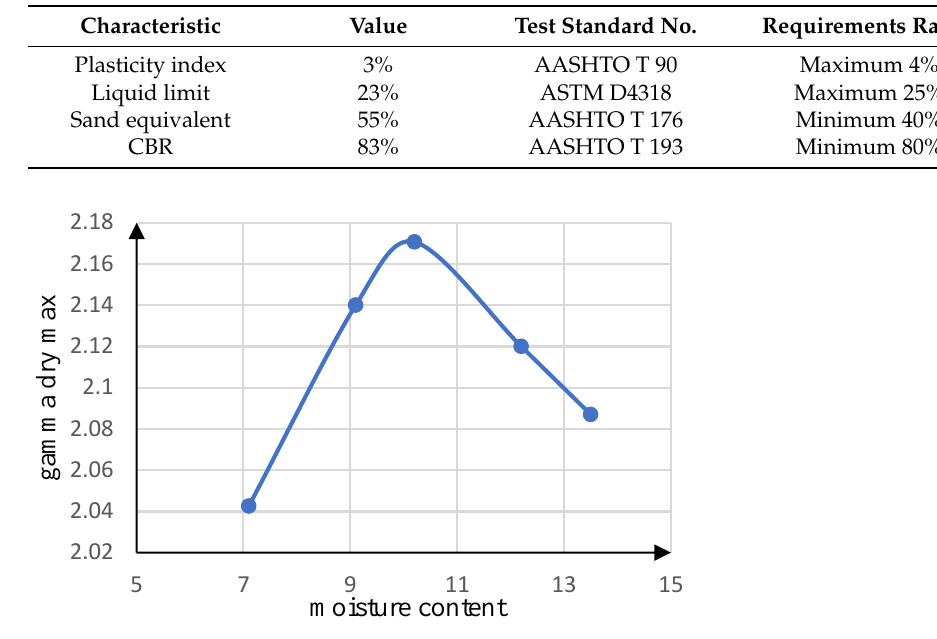
Figure 3. Standard compaction curve of the utilized soil. Table 1. Characteristics of the employed soil as the base layer material.